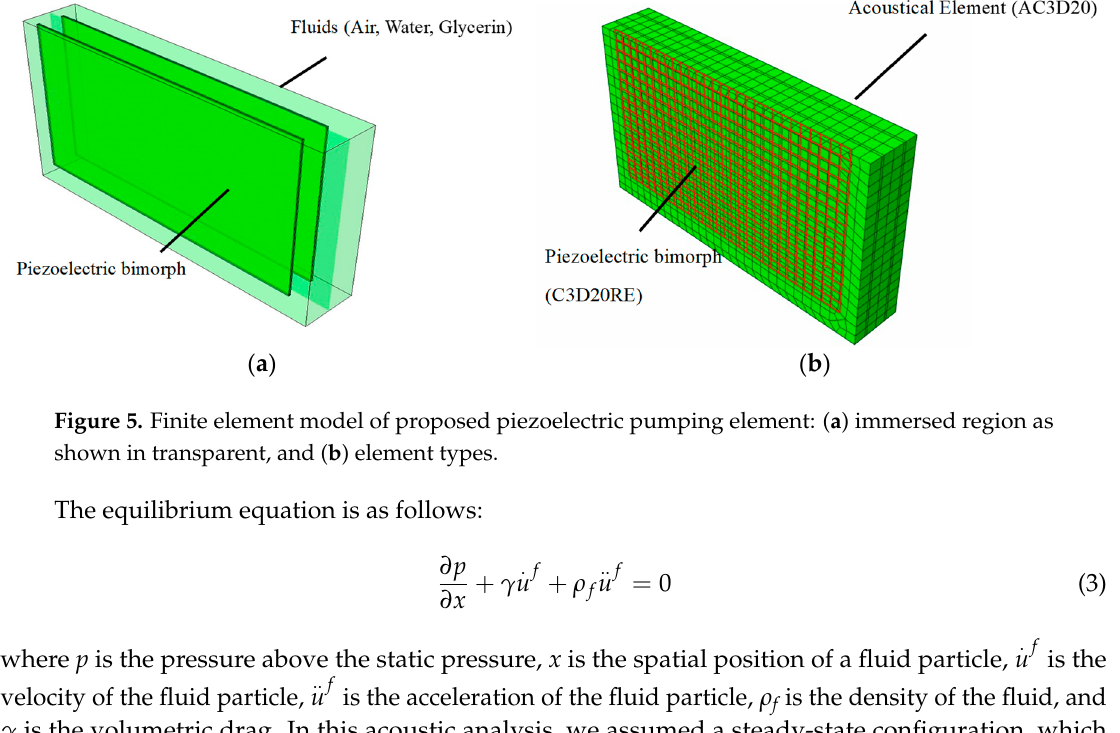
Table 2. Material properties of fluids.